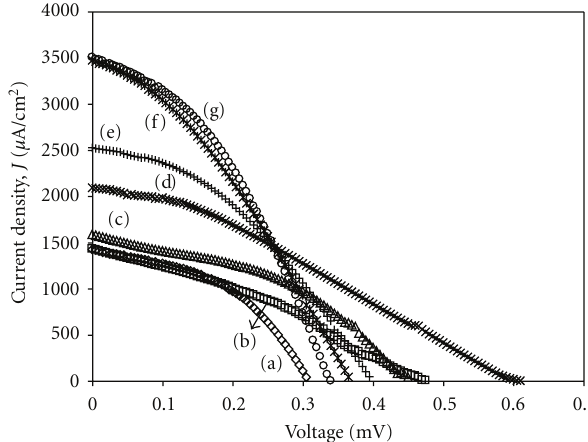
Figure 8: J - V characteristics of the red cabbage DSSCs for sample (a) HCl as pH adjuster and 27.5 wt. % chitosan-22.5 wt. % NH 4 I- 50wt. % BMII gel electrolyte, (b) tartaric acid as pH adjuster and 27.5wt. % chitosan-22.5 wt. % NH 4 I-50wt. % BMII gel electrolyte, (c) HCl as pH adjuster and 11wt. % chitosan-9 wt. % NH 4 I- 80wt. % BMII gel electrolyte, (d) tartaric acid as pH adjuster and 11wt. % chitosan-9wt. % NH 4 I-80wt. % BMII gel electrolyte, (e) tartaric acid as pH adjuster and 11 wt. % (chitosan:PEO, wt. ratio 30:70)-9wt. % NH 4 I-80wt. % BMII gel electrolyte, (f) tartaric acid as pH adjuster and 11 wt. % phthaloyl chitosan-9wt. % NH 4 I- 80wt. % BMII gel electrolyte and (g) tartaric acid as pH adjuster and 11wt. % (chitosan : PEO, wt ratio 30 :70)-9wt. % NH 4 I- 80wt. % BMII gel